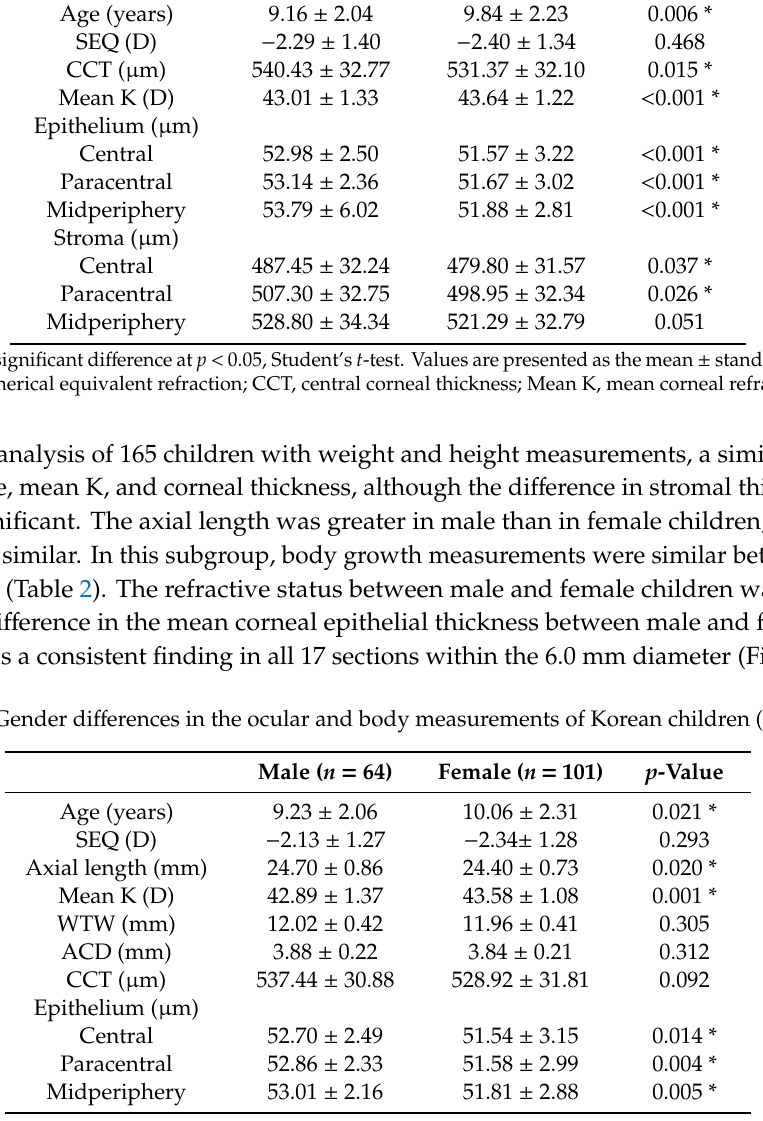
Table 1. Corneal epithelial and stromal thickness in Korean school children ( n = 323). Male ( n = 122)